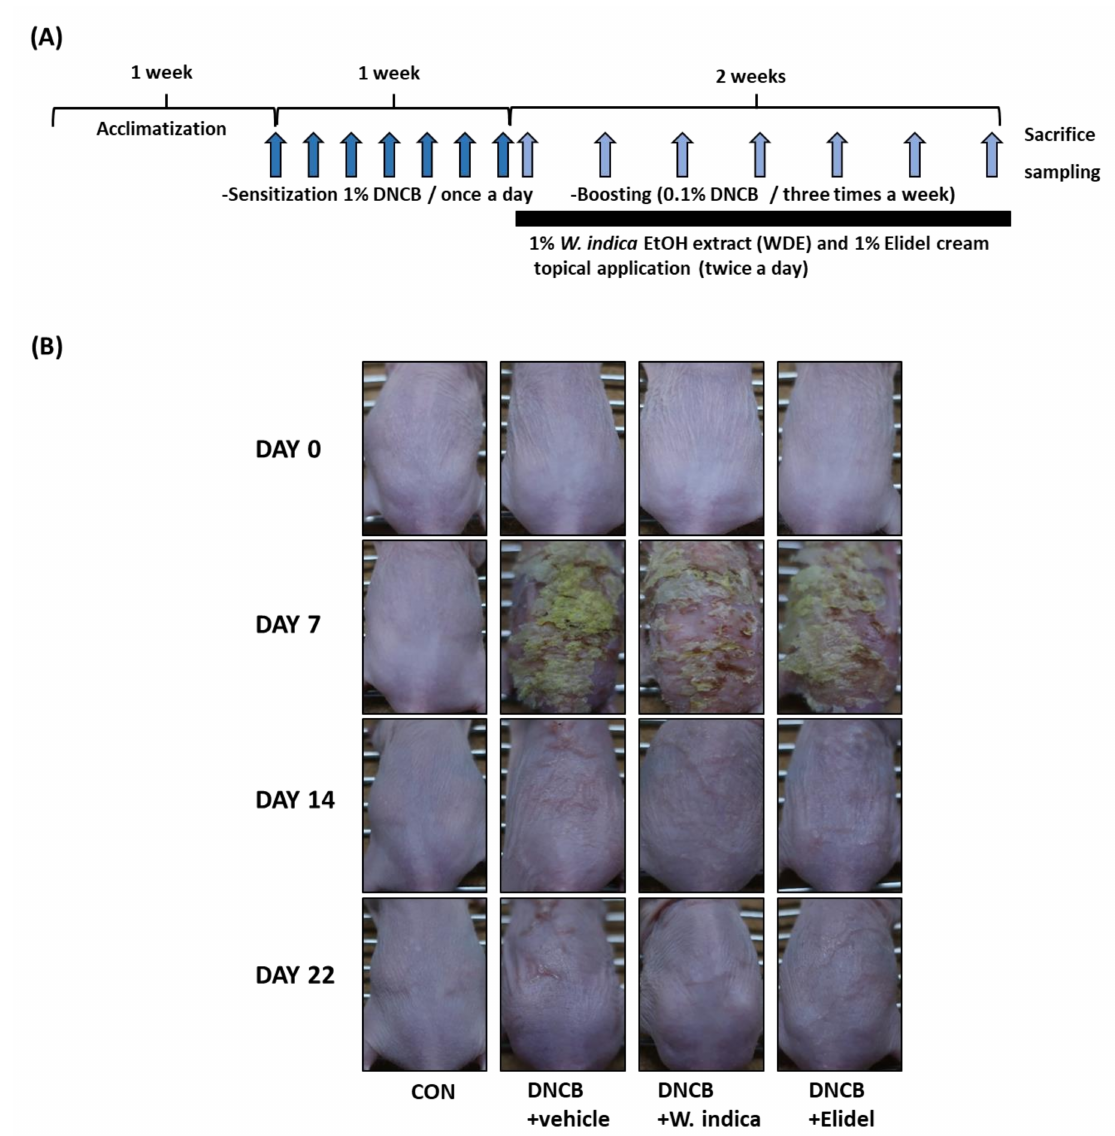
Figure 1. E ff ects of W. indica on the development of 2,4-dinitrochlorobenzene (DNCB)-induced AD-like skin lesions in SKH-1 hairless mice. ( A ) Schematic representation of the experiment. ( B ) Clinical features of DNCB-induced AD-like skin symptoms. CON: vehicle control group; DNCB + vehicle: DNCB-treated control group; DNCB + W. indica : DNCB plus 1% W. indica -extract treated group; and DNCB + Elidel: DNCB plus 1% pimecrolimus treated